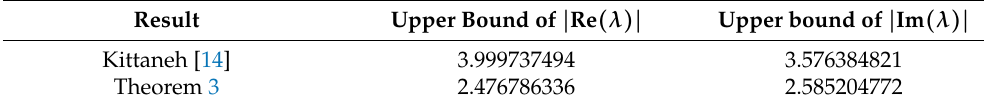
Table 2. Comparisons of upper bounds based on the considered polynomial q 2 ( z ) . Result Upper Bound of | Re ( λ ) | Upper bound of | Im ( λ )